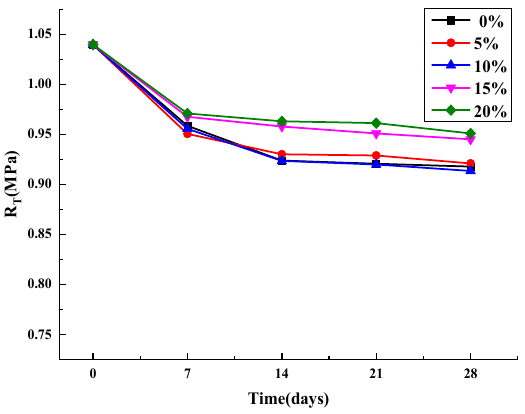
Figure 9. Soaking directly splitting strength.